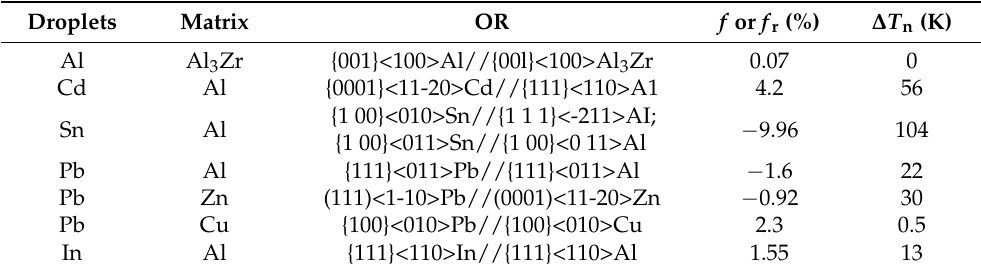
Figure 23. Nucleation undercooling (from MD simulations) v.s. absolute value of lattice misfit. Nucleation undercooling ( ∆ T n ) obtained by MD simulations is plotted as a function of lattice misfit ( f ) or residual misfit ( f r ). It shows that ∆ T n is a unique linear function of lattice misfit | f |. The linear fitting of the MD data suggests that ∆ T n = 17.82| f | with R 2 = 0.978. The scatter of data is mainly caused by the variation of size of the simulation systems since ∆ T n decreases slightly with increasing the size of the simulation cells. Table 1. Orientation relationship (OR), misfit ( f ) or residual misfit ( f r ) and nucleation undercooling ( ∆ T n ) derived from experimental results on solidification of droplets embedded in matrix from the literature [25,28,31,71–74]. The OR was examined by transmission electron microscopy and electron probe microanalysis, the misfit was calculated according to the OR, and the ∆ T n was obtained by differential scanning